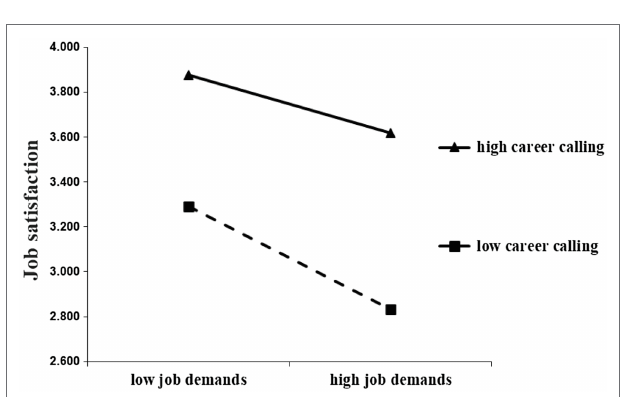
FIGURE 4 | Moderating effect of career calling in the relation between job demands and job